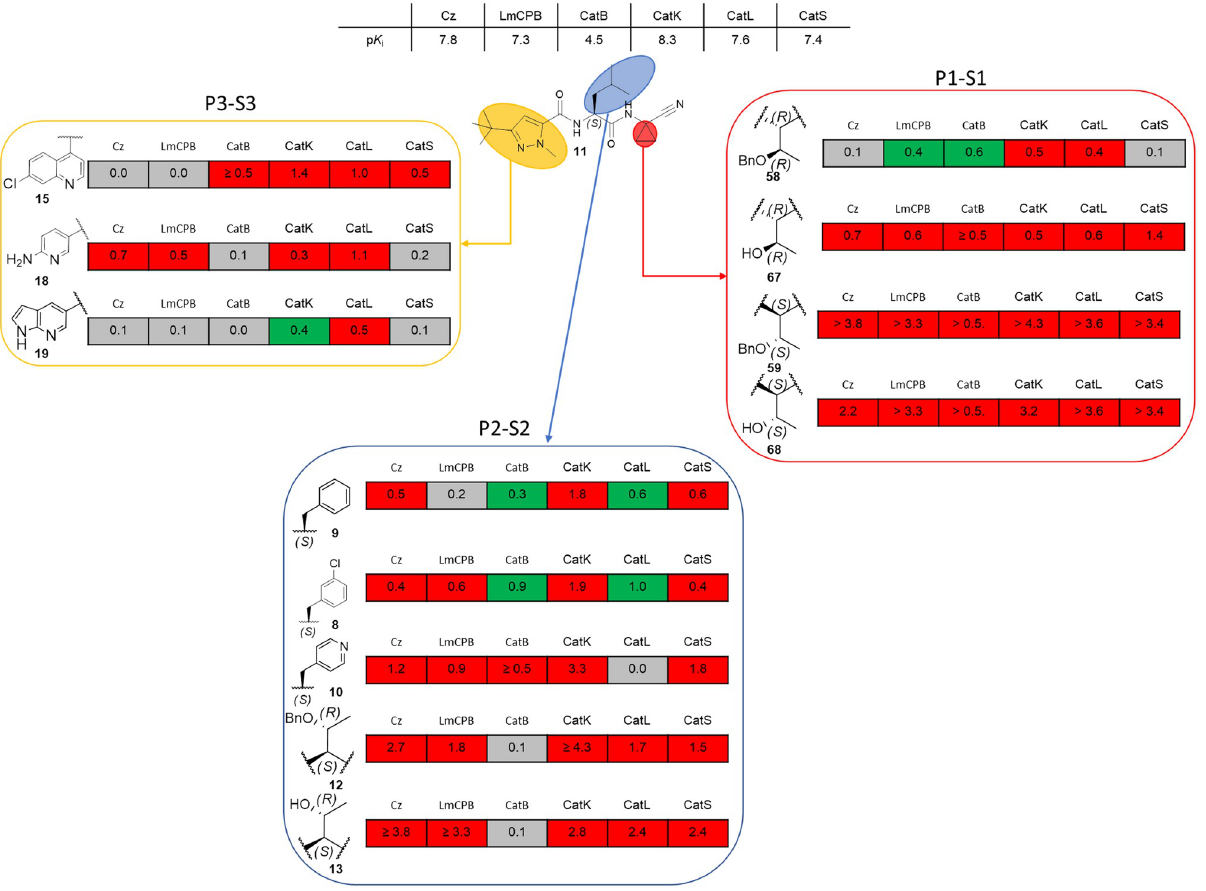
Fig 9. SAR summary starting from compound 11. Values are reported as differences in p K i and are color-coded as red (negative), green (positive), grey (no significant difference, Δ p K i < 0.2).